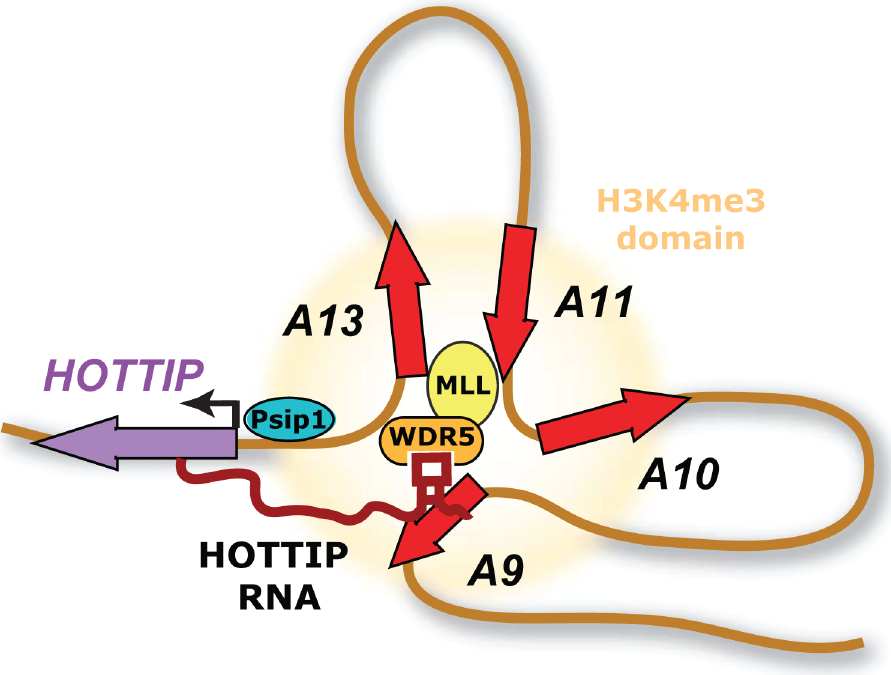
Fig 1. Model of positive cofactor 4 (PC4) and splicing factor 2 (SF2) interacting protein (Psip1) action. Psip1 activates the transcription of Hottip long noncodingRNA (lncRNA) in distal limb cells. Hottip lncRNA in turn stimulatesthe transcription of 5 0 HoxA genesby enforcing H3K4me3chromatinmodification. Hottip’s selective effect on 5 0 HoxA genes is due to the chromosome loopingthat brings 5 0 HoxA genes into the vicinity of Hottip RNA emanating from the Hottip DNA locus. This mechanism transmits the spatialinformation in DNA loopinginto chemical informationin chromatinmodificationand gene activation. Abbreviations: WDR5, WD repeat-containingprotein 5; MLL, mixed lineage